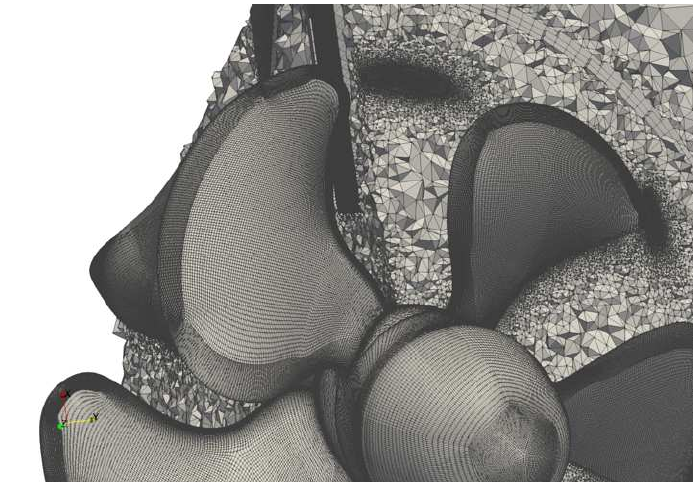
Figure 5. Closer view of surface and volume mesh close to the propeller blades. Table 6. Cell counts for case Kongsberg propeller